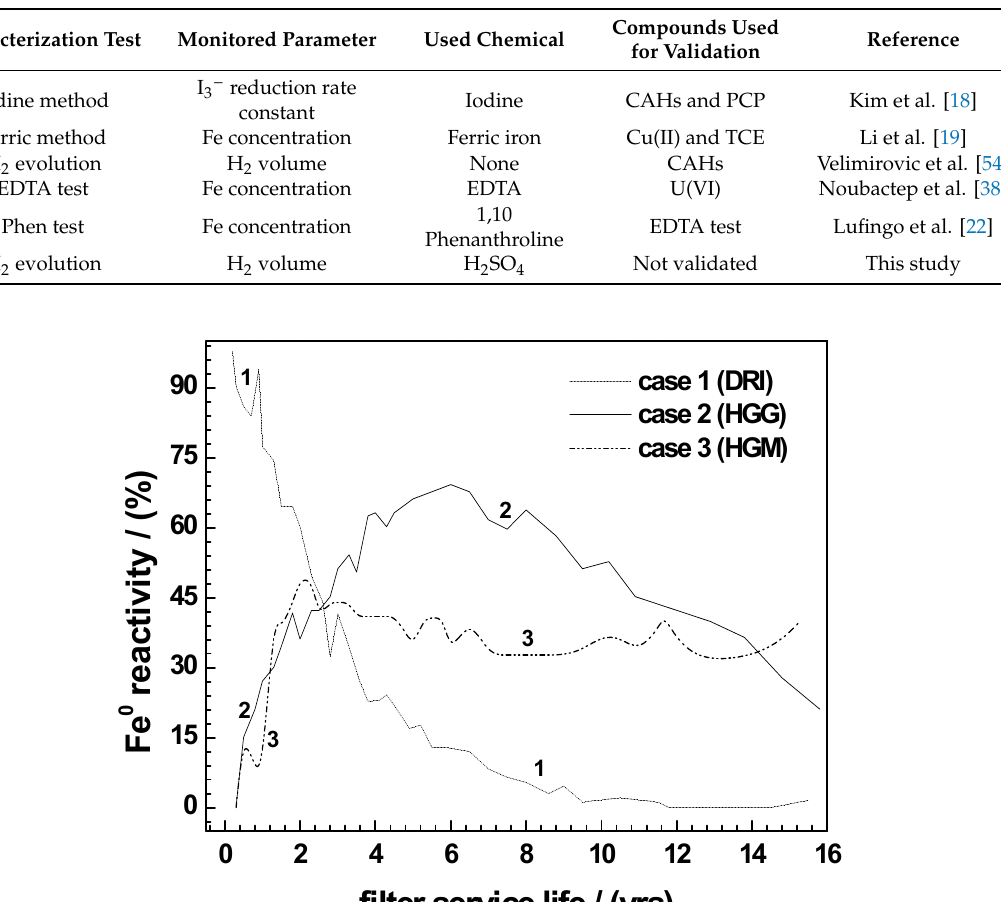
Table 5. Summary of the existing Fe 0 materials reactivity characterization methods validated via comparison of results with that of contaminant removal. “CAHs” stand for “chlorinated aliphatic hydrocarbons” and “PCP” for “Pentachlorophenol”.